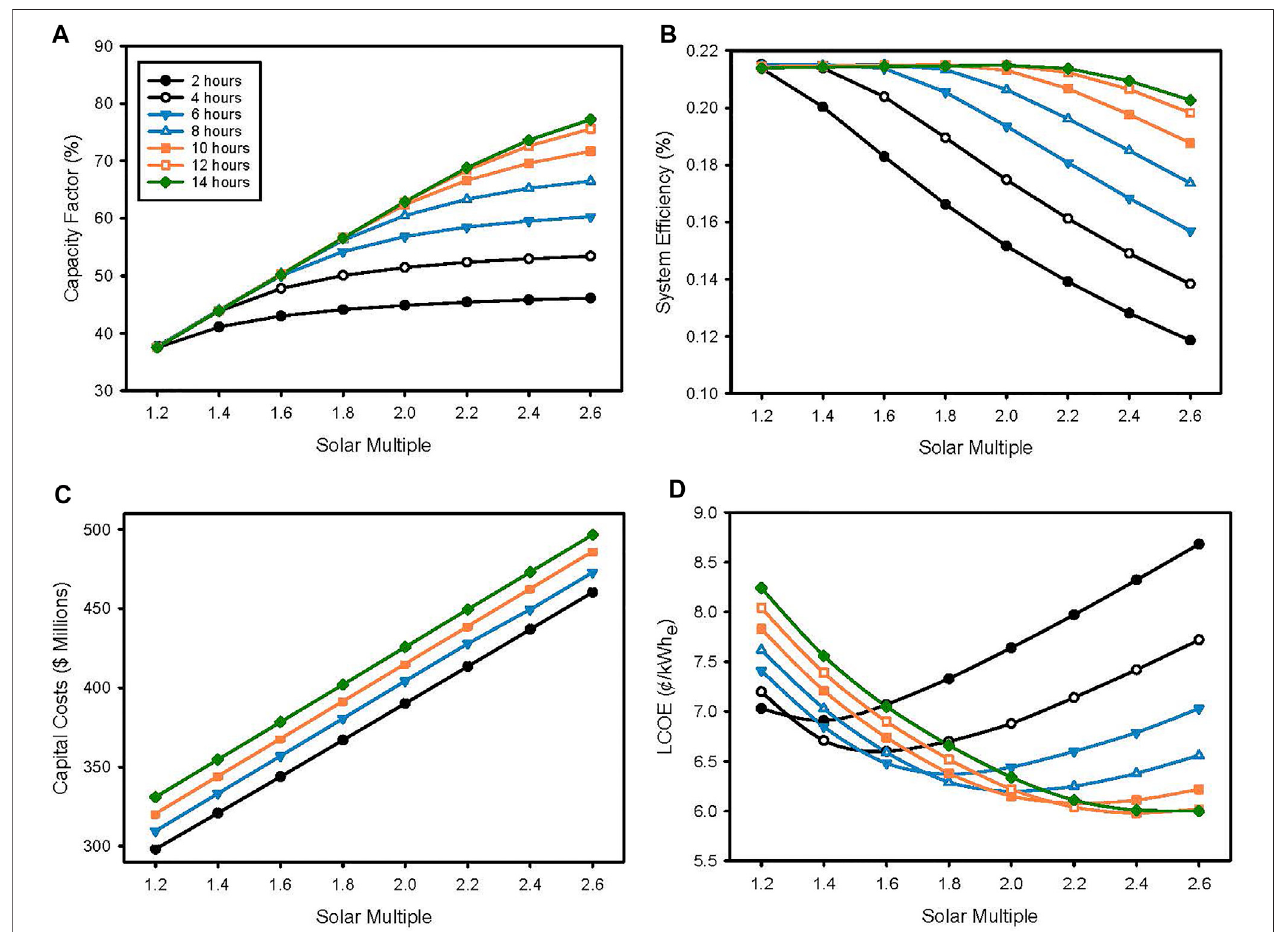
FIGURE 5 | Effect of storage capacity and solar multiple on (A) capacity factor, (B) system ef fi ciency, (C) total capital cost, and (D) LCOE.